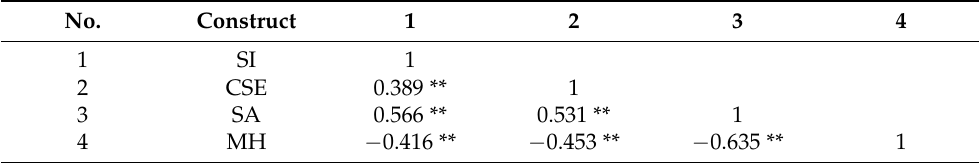
Table 2. Descriptive statistics and cross-variable correlation.